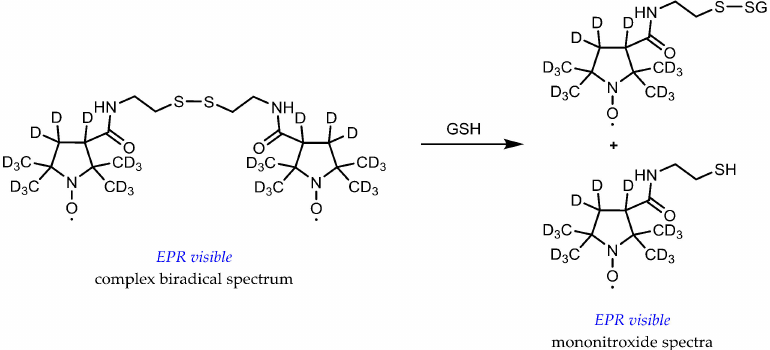
Figure 7. Principle of disulfide-linked dinitroxide spin probes for glutathione redox status